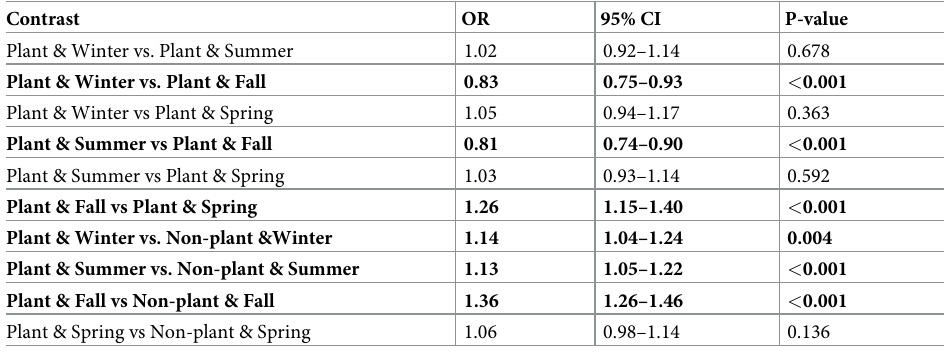
� Contrasts based on model presented in Table